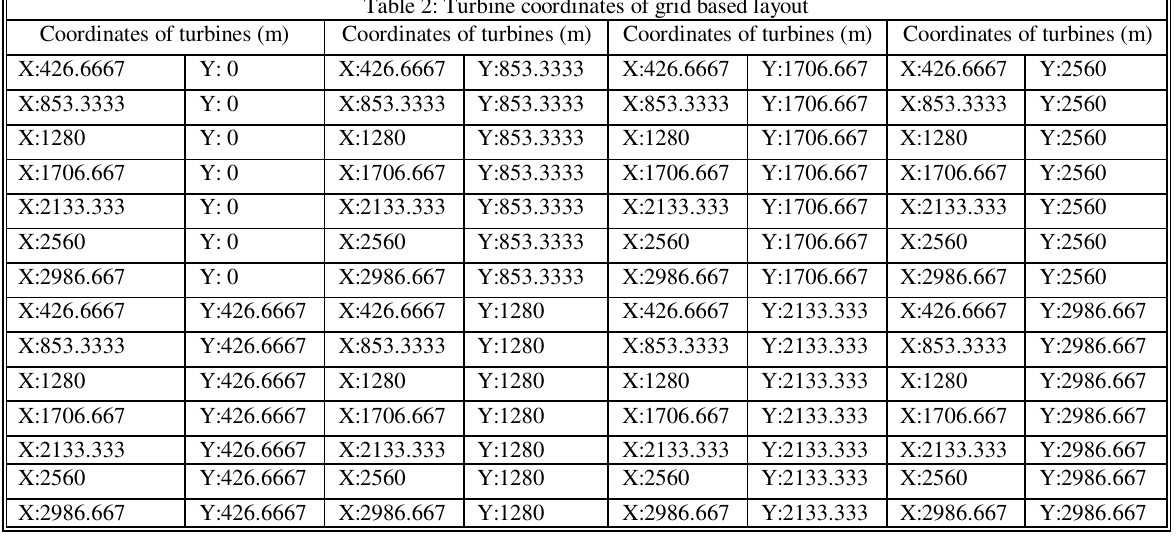
Table 2: Turbine coordinates of grid based layout Coordinates of turbines (m) Coordinates of turbines (m) Coordinates of turbines (m) Coordinates of turbines (m)